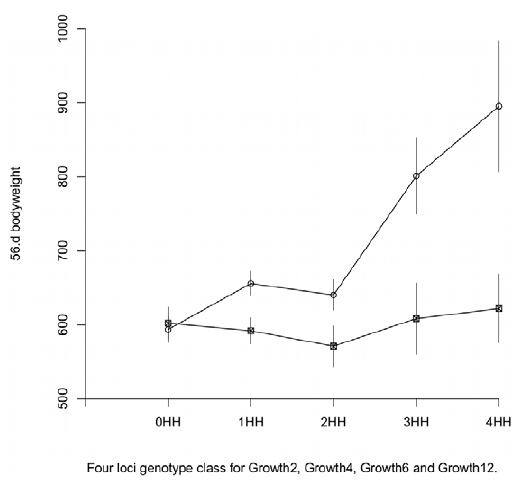
Figure 3. Genotype-phenotype maps in HWS and LWS genetic background at Growth9.1 . Model free estimation of phenotypic values. The values are plotted as a function of the degree of HWS and LWS homozygosity at its interacting loci Growth2 , Growth4 , Growth6 and Growth12 . The error bars represent s.e.m. Circles are Growth9 HH and squares are Growth9 LL.